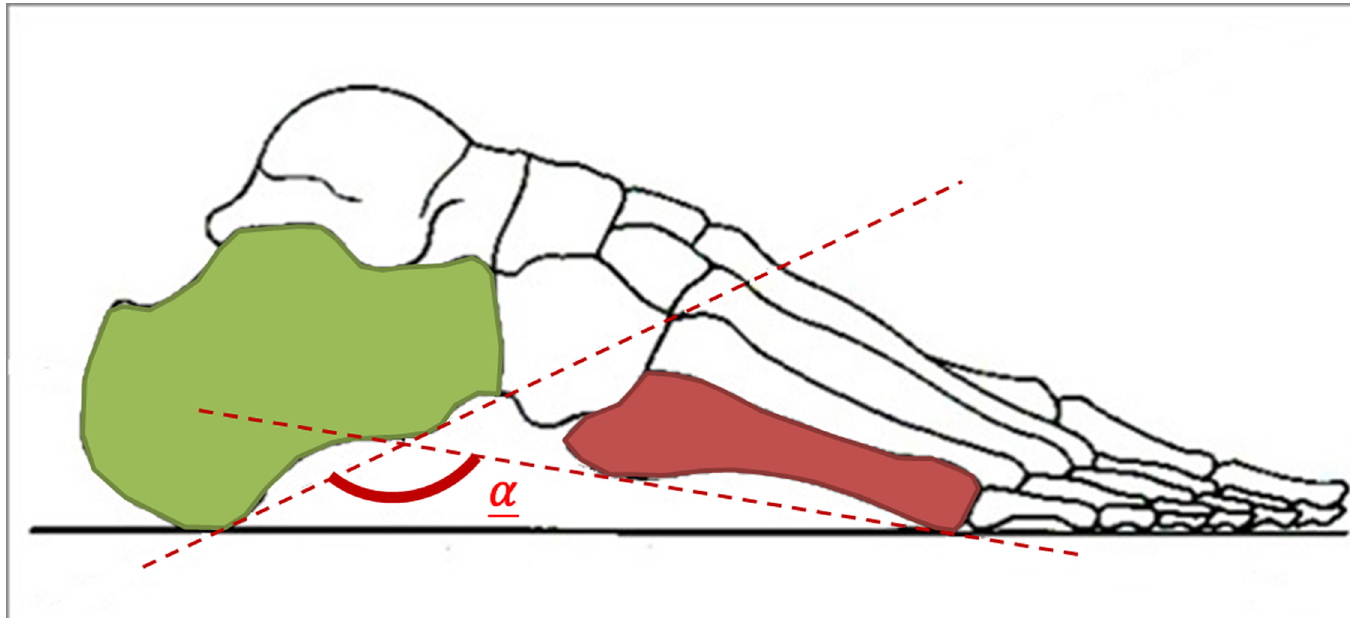
Fig 1. The illustration of calcaneal-fifth metatarsal angle (CA – MT5 angle) α . Diagram of the lateral radiographic images of a participant, which illustrates that the calcaneal-fifth metatarsal angle (CA – MT5 angle) α , also called the arch angle, is defined by lines at the calcaneus and fifth metatarsal. In Taiwan, the criteria for new military conscripts include that individuals are required to serve mandatory service if they have an arch angle < 165°, substitute service if they have an angle between 165° to 168°, and are exempt from military service if their arch angle >